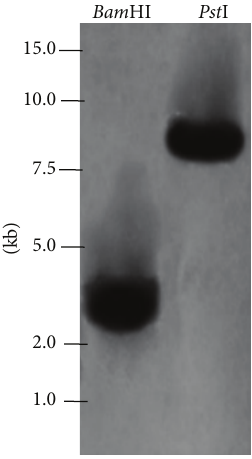
Figure 5: Southern blot analysis of GbWRKY2 . Genomic DNA of G. biloba was digested with Bam HI and Pst I, separated on a 0.85% agarose gel, blotted onto a positively charged nylon membrane and probed with a biotin-labeled GbWRKY2